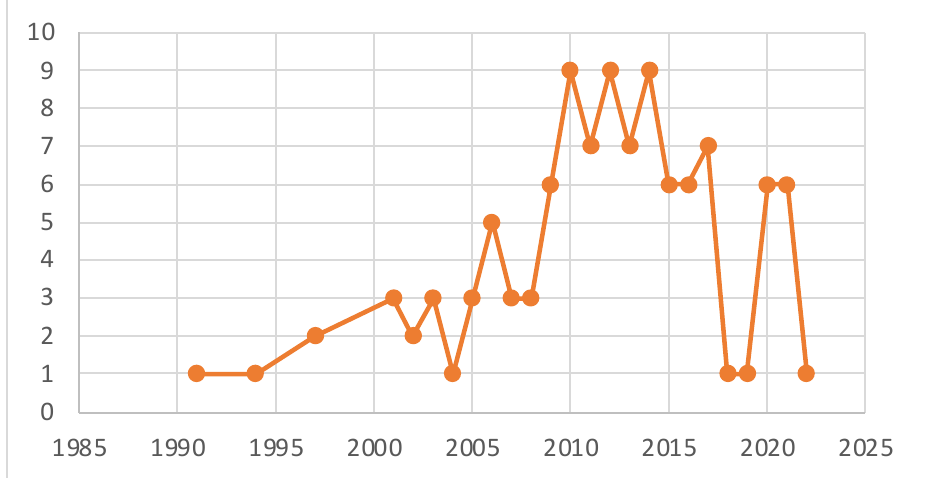
Figure 1. Analyzed articles in this study by year of publication.